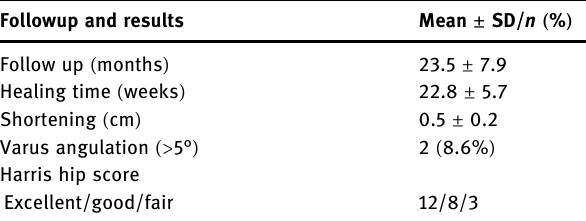
Table 3: Follow up and functional outcome Followup and